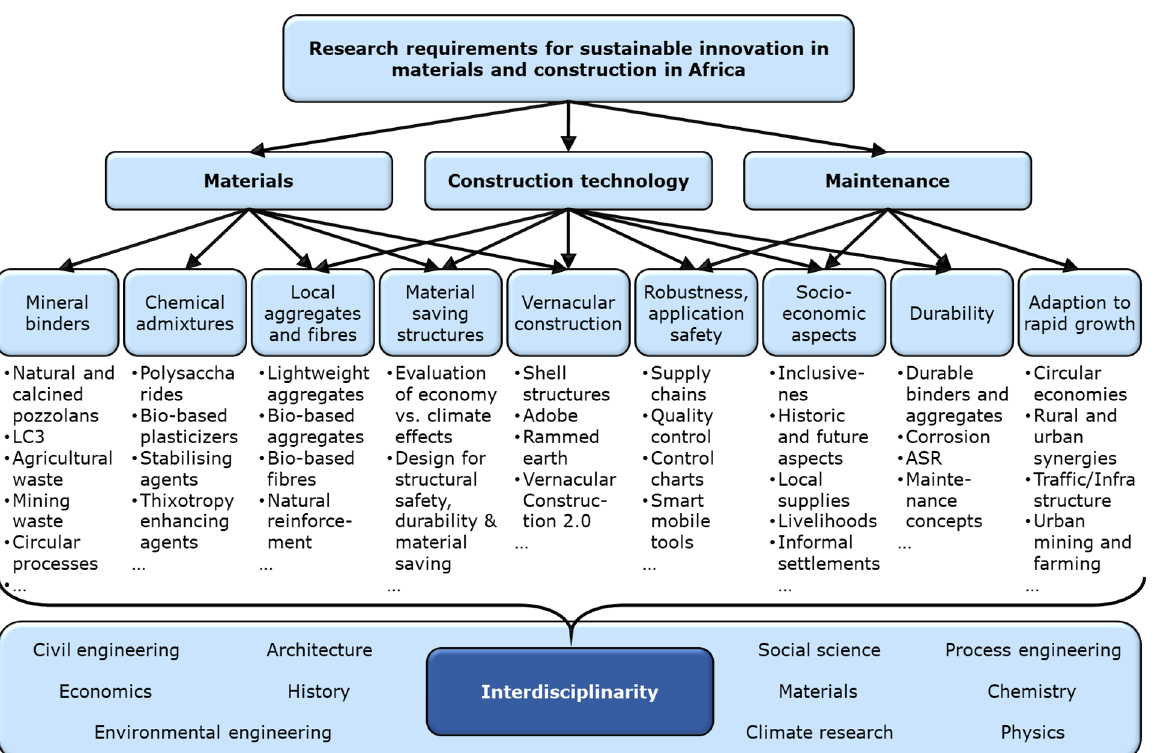
Figure 4. Summary of climate and society relevant trans ‐ disciplinary research focal areas related to challenges and potentials in construction in